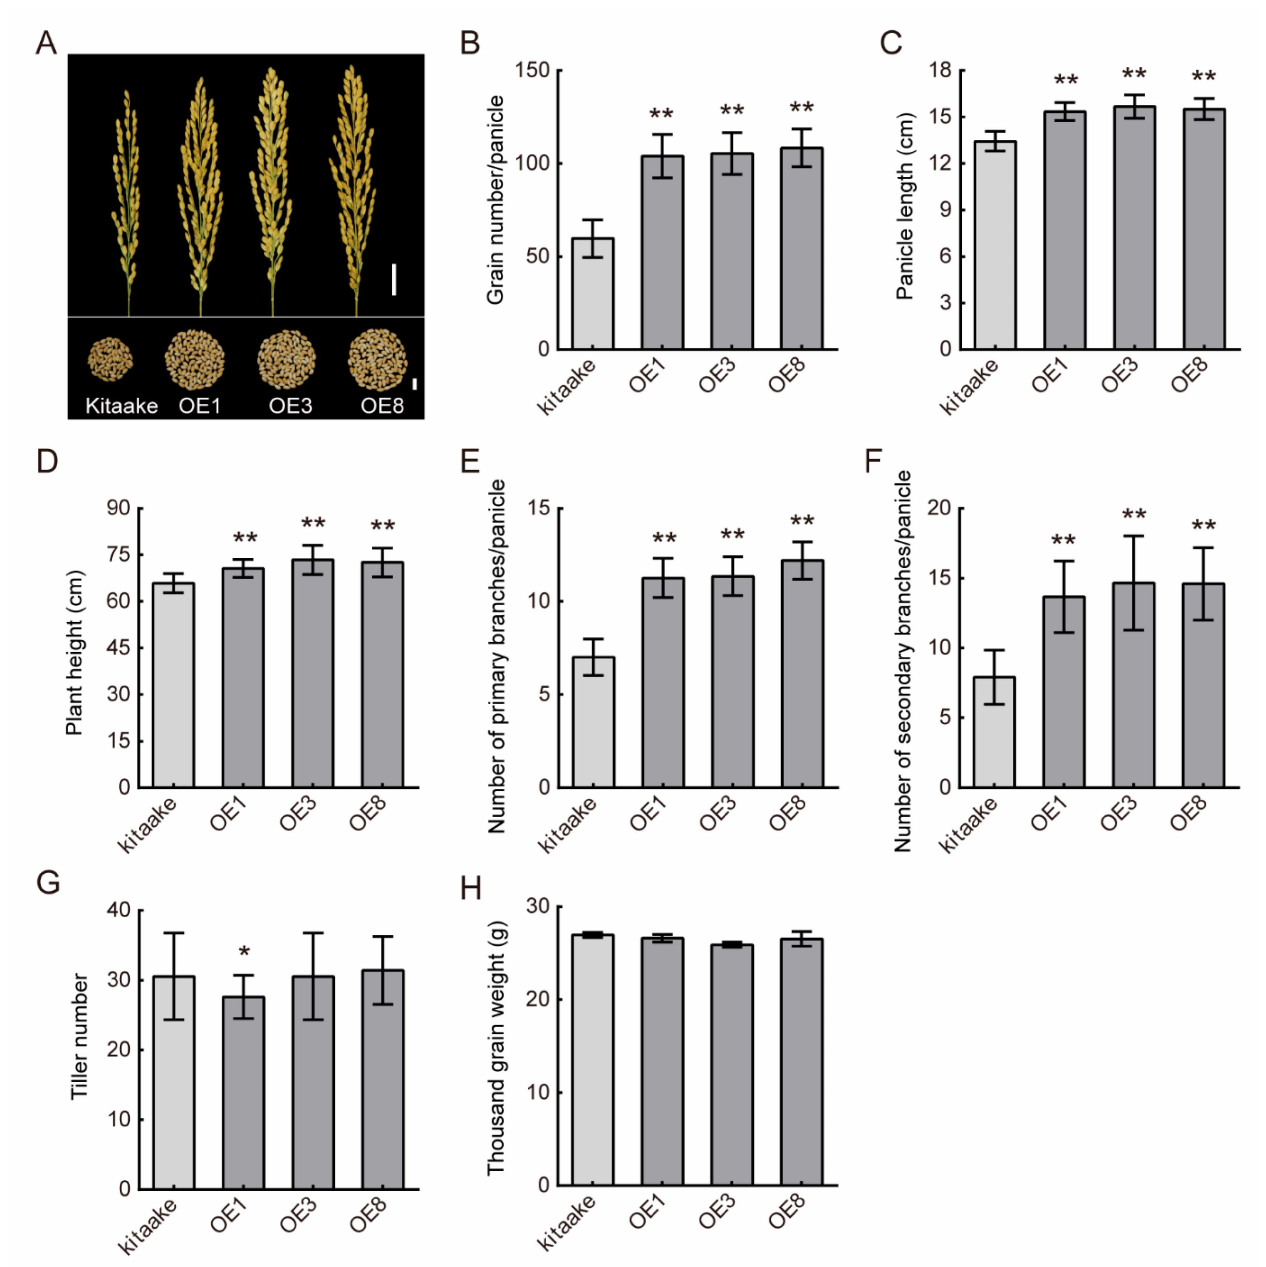
Figure 2. Agronomic traits of wild type Kitaake and overexpressed lines when planted in a paddy field under NLD conditions. ( A ) Main panicle size and grains on the main panicle of WT and DHD3 overexpressed plants. Scale bars, 2 cm (above) and 10 mm (under). ( B ) Grain number of the main panicle. ( C ) The panicle length of the main panicle. ( D ) Plant height. ( E ) Number of primary branches of the main panicle. ( F ) Number of secondary branches of the main panicle. ( G ) Tiller number. ( H ) Thousand-grain weight. Data are means ± s.e. ( n > 15). Statistical significance is indicated by * p ≤ 0.05 and ** p ≤ 0.01; one-way ANOVA test with Tukey